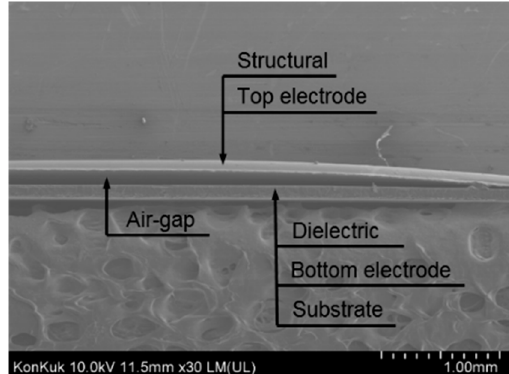
Figure 7. FE-SEM image of an air-gap touch sensor sample.